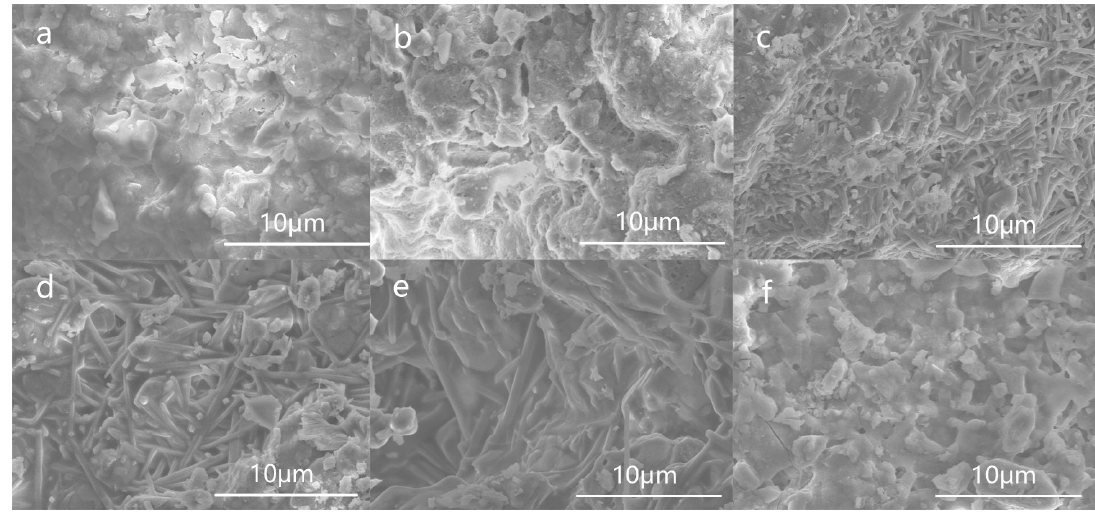
Figure 3. SEM images of the specimens sintered at (a) 1250°C, (b) 1300°C, (c) 1350°C, (d) 1400°C, (e) 1450°C and (f) the fractured section of the samples sintered at 1250°C.